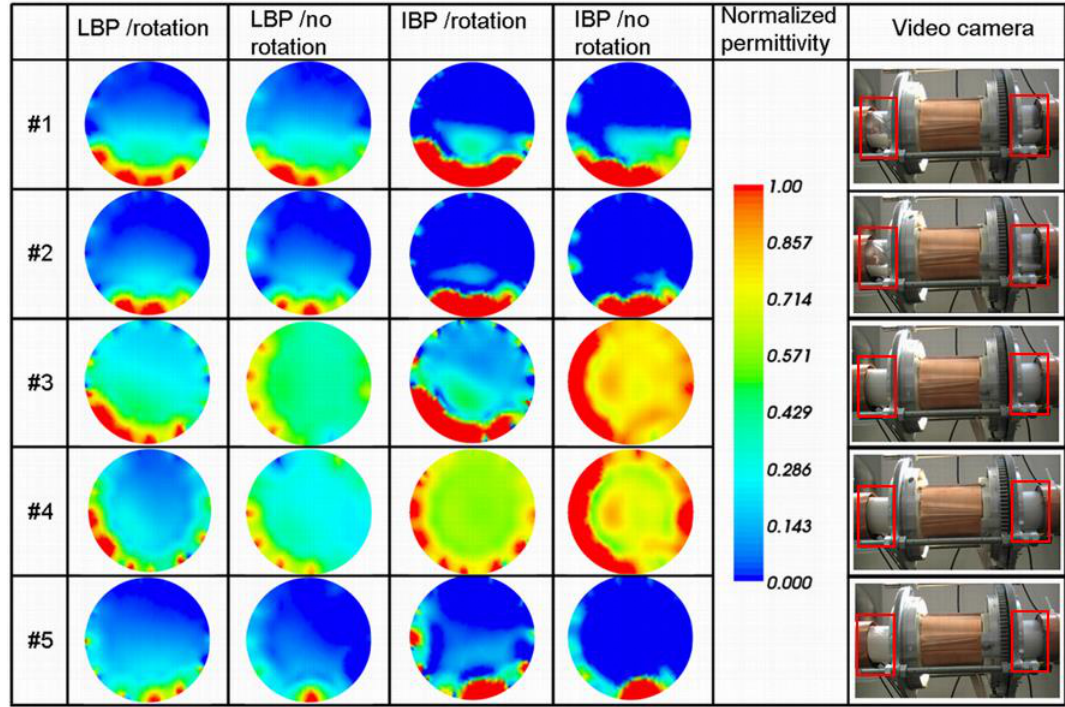
Figure 5. Qualitative comparison of the 2 different image reconstruction techniques (linear back projection (LBP) and iterative back projection (IBP)) taking into account rotation or 1 position for the 5 flow events. The legend corresponding to the normalized permittivity in the different images, as well as screenshots of the corresponding sequence of the recorded movie, are also shown.